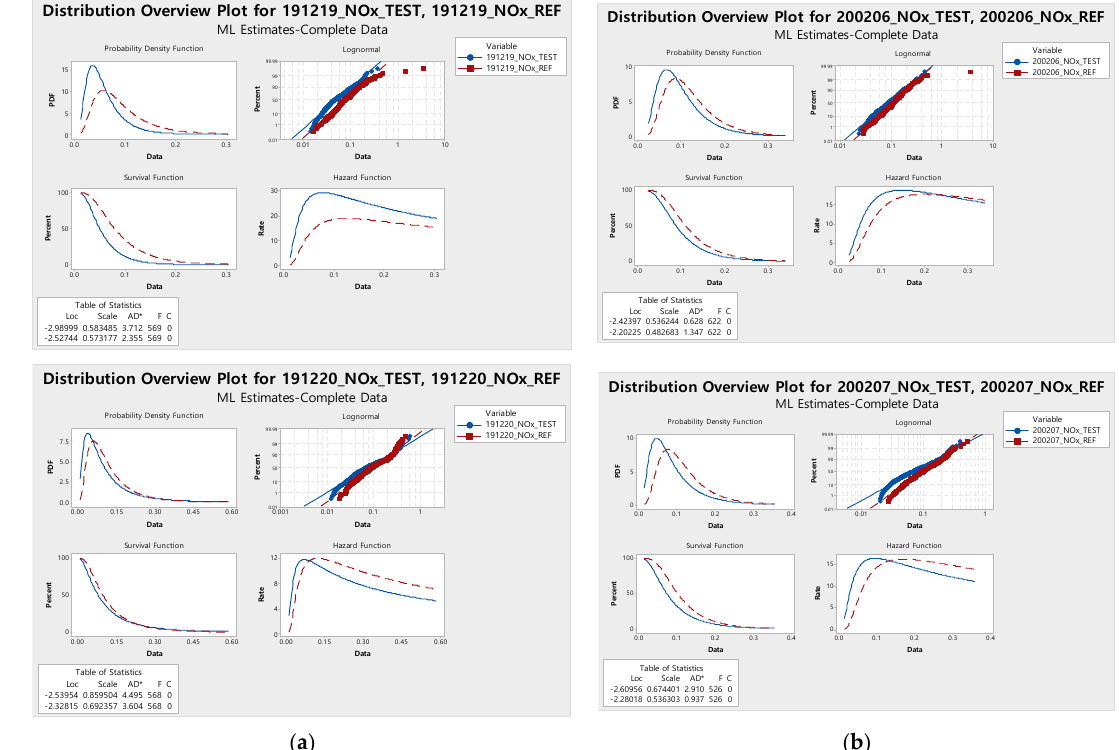
Figure 2. Probability distributions and probability density functions of the Anderson ‐ Darling test for the test and reference sections: ( a ) Date of measurement: 6 to 20 December 2019; ( b ) Date of measurement: 3 to 7 February 2020.